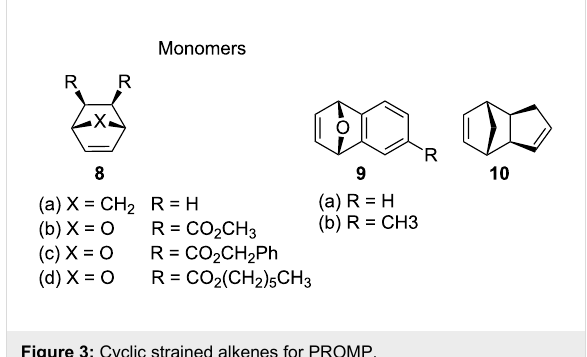
Figure 3: Cyclic strained alkenes for PROMP.